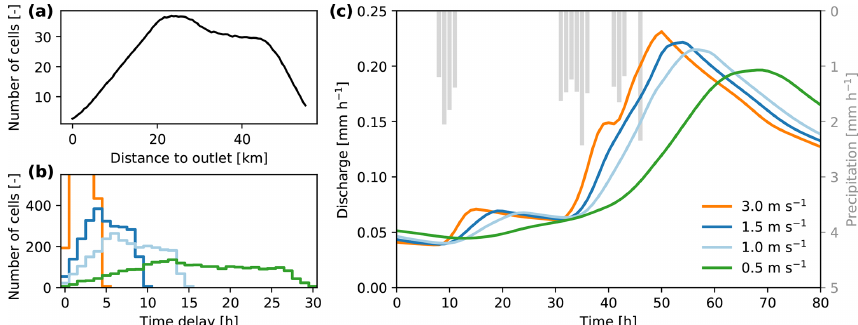
Figure 4. The routing concept visualized: (a) the width function of a synthetic catchment, (b) the corresponding travel speed given four different τ values and (c) the effect of different τ values on the hydrograph.